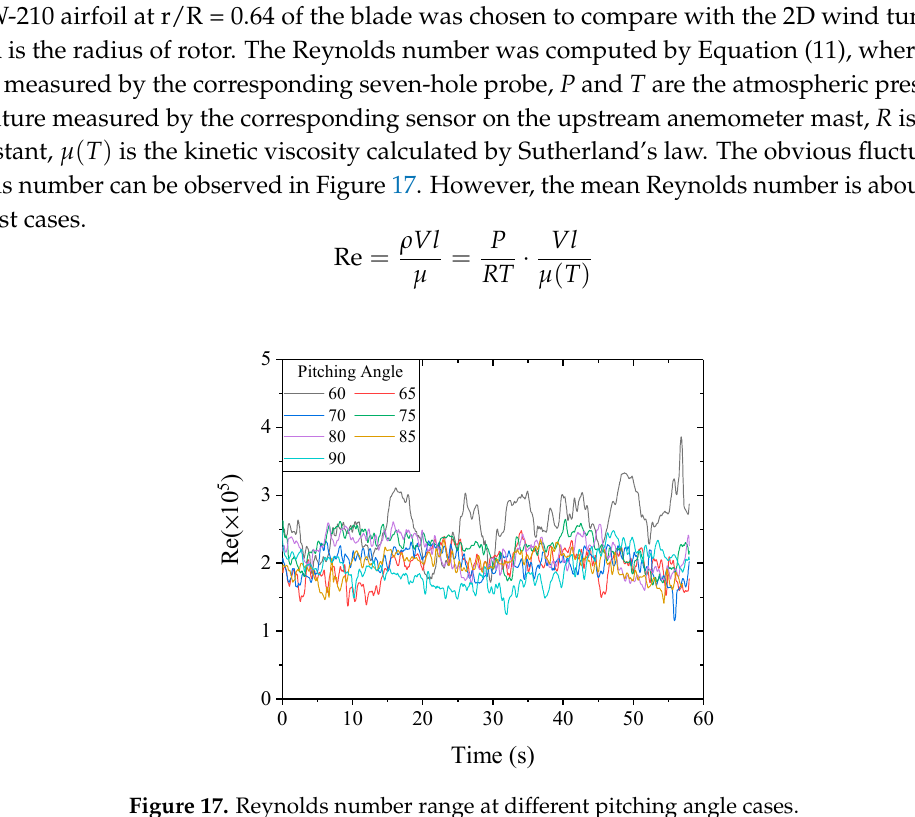
Figure 16. Angle-averaged lift coefficients from each pitching angle case ( a ) and all the cases ( b ).